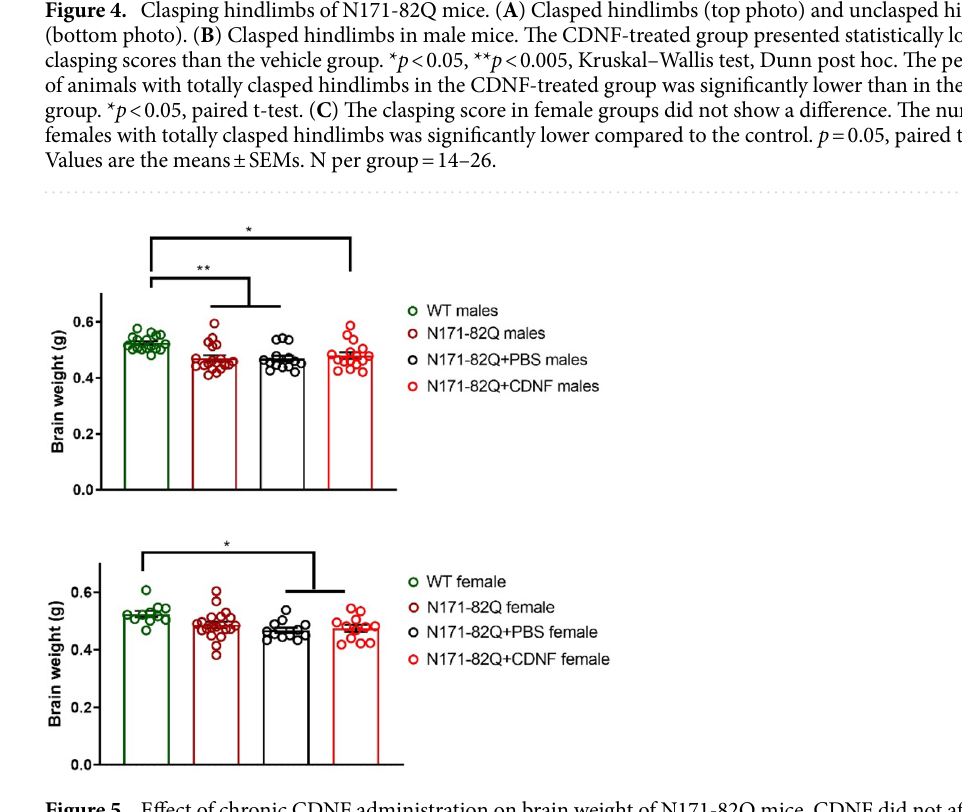
Figure 5. Effect of chronic CDNF administration on brain weight of N171-82Q mice. CDNF did not affect brain weight compared to vehicle in two genders. Values are means ± SEM. * p < 0.05, ** p < 0.001, one-way ANOVA, Turkey’s post hoc test. N number per group =